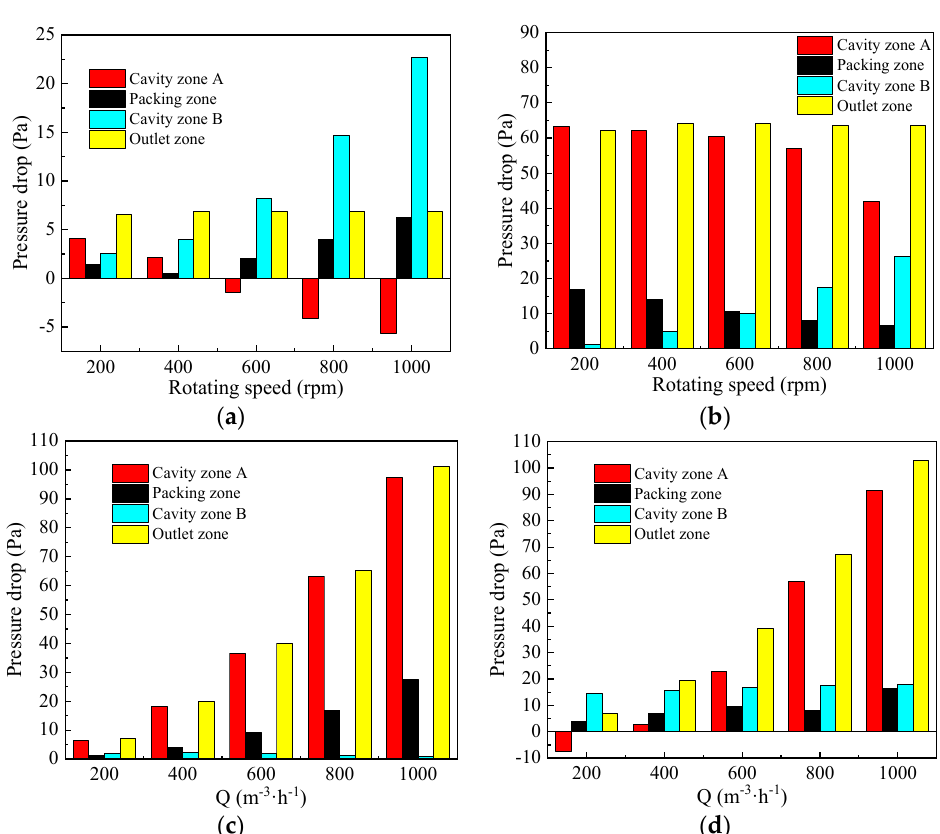
Figure 15. Comparing the pressure drop in different zones. ( a ) Gas flow rate of 200 m 3 ·h − 1 ; ( b ) gas flow rate of 800 m 3 ·h − 1 ; ( c ) rotating speed of 200 rpm; ( d ) rotating speed of 800 rpm.